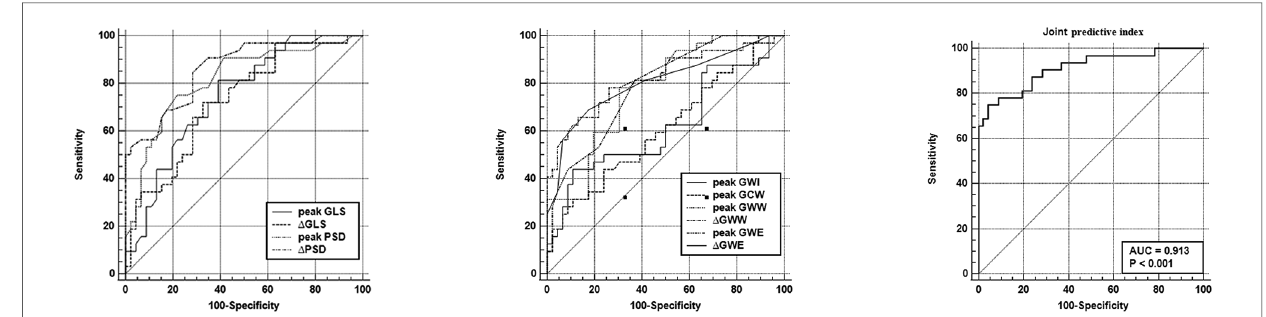
FIGURE 4 Receiver operating characteristic analysis of 2D-STE related indices, MW related indices and combined forecast metrics for predicting CMD. GLS, global longitudinal strain; PSD, peak strain dispersion; GWI, global work index; GCW, global contractive work; GWW, global waste work; GWE, global work ef fi ciency.